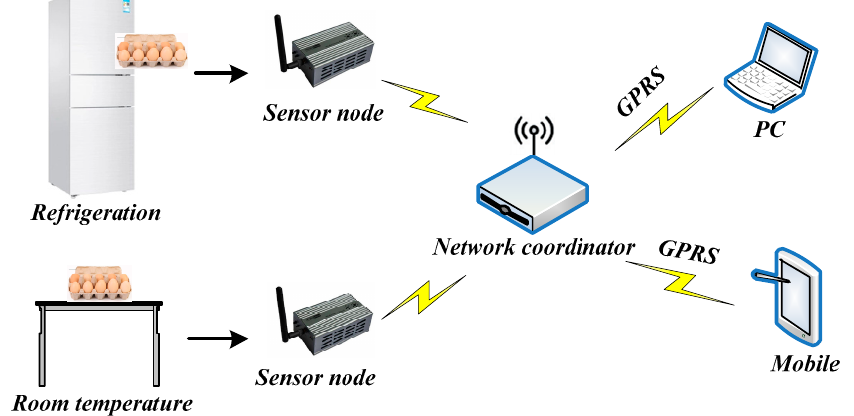
Figure 1. Architecture diagram of the Wireless sensor network (WSN). GPRS, General Packet Radio Service. PC, personal computer.